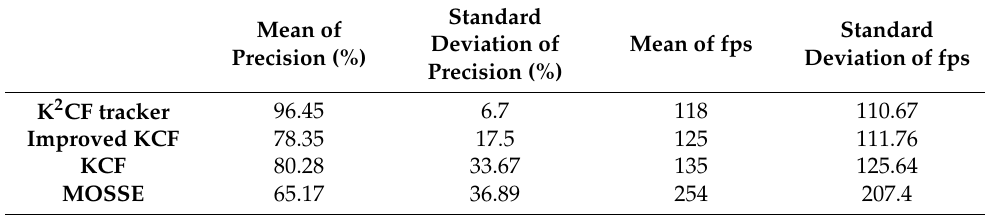
Table 1. Average precision and frame fps of 4